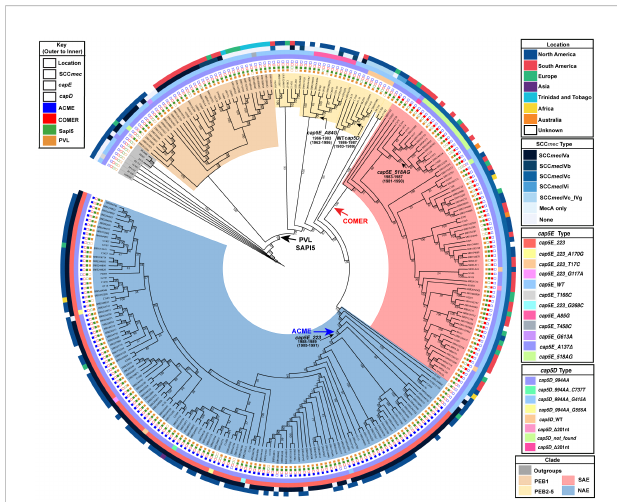
FIGURE 1 Maximum likelihood tree of 276 S. aureus genomes: From outer to inner track: Isolation location, SCC mec type, cap5E allele type, cap5D allele type are shown for each genome. Presence or absence of key genetic elements are indicated with solid or hollow squares. Introduction of key genetic elements are indicated. White squares indicate missing data. Bootstrap values are indicated for each